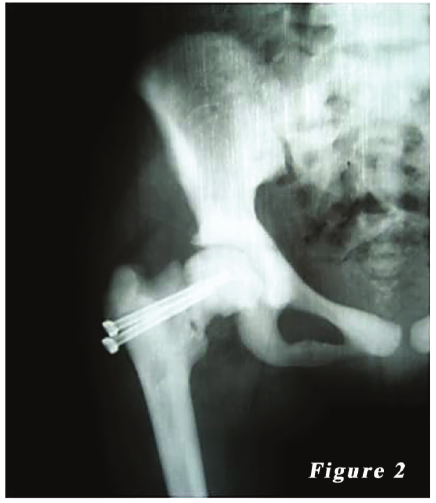
Figure 2: Postoperative radiography of the first patient.